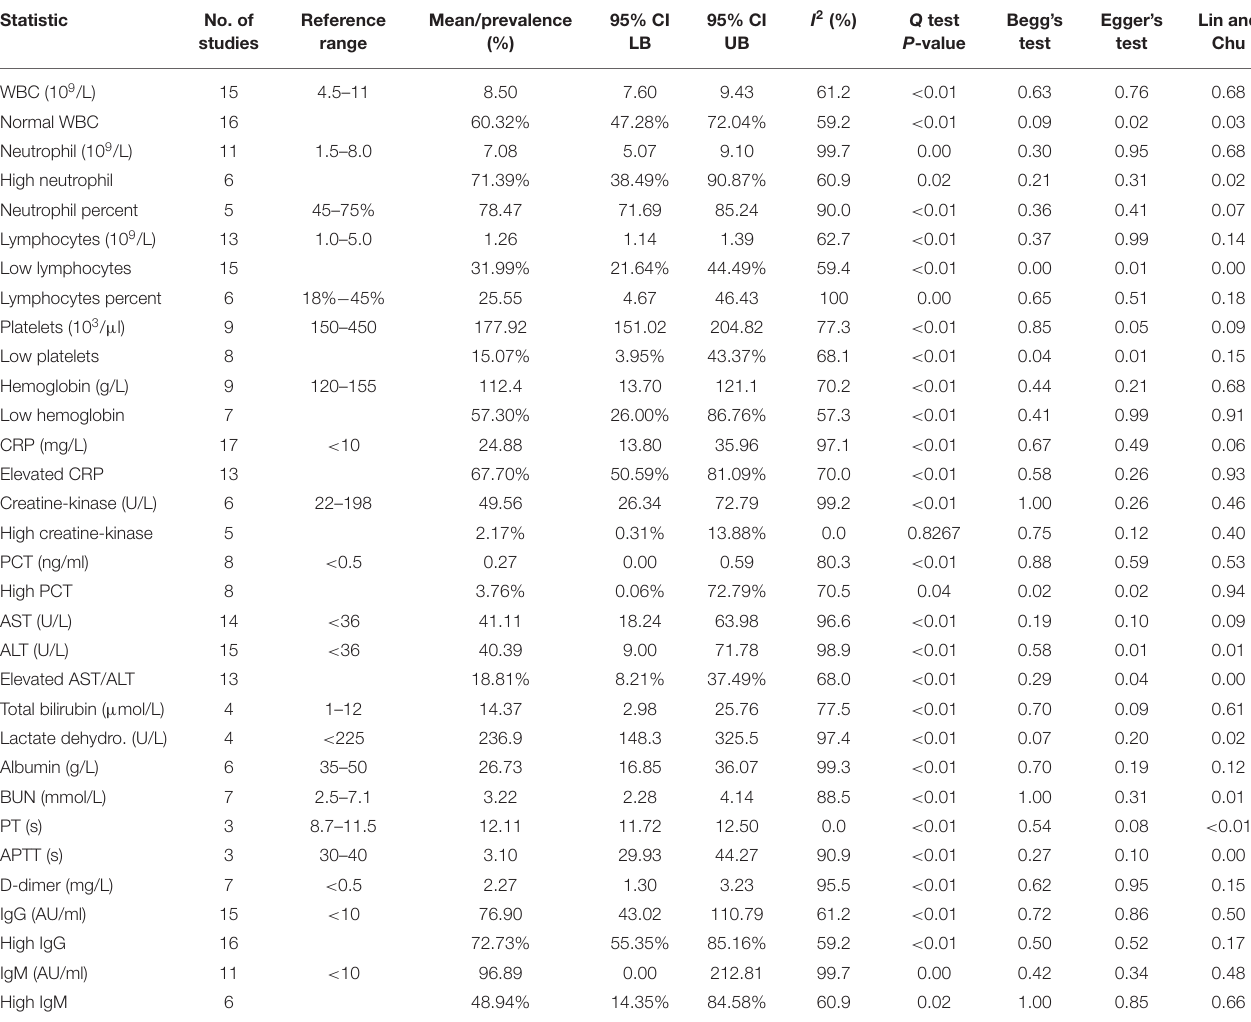
TABLE 4 | Meta-analysis of maternal laboratory tests and